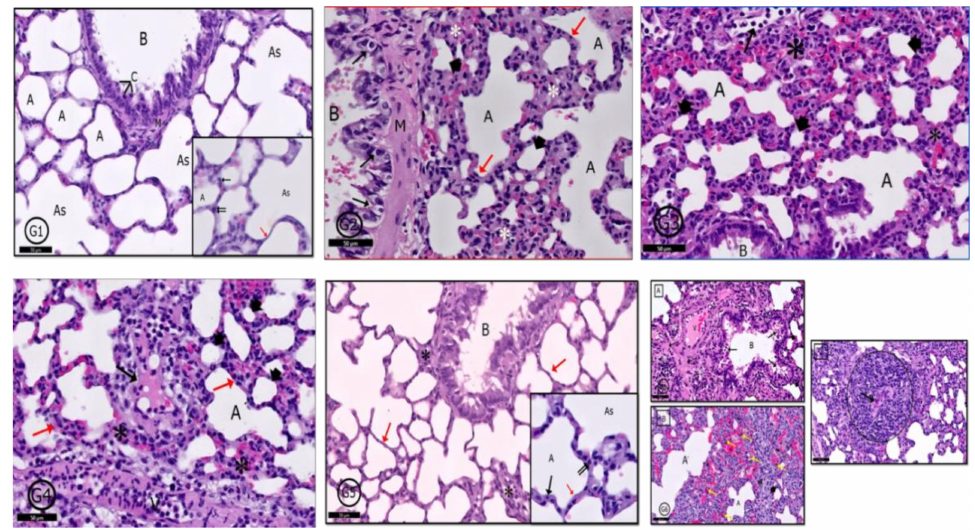
Figure 11. Photomicrographs of the rat lung of different groups: ( G1 ) (control rats) showed normal pulmonary profile as a bronchiole (B), alveolar sacs (As), alveoli (A) separated by interalveolar septa (red ↑ ) and arterioles (Ar). Clara cells (C), pneumocyte type I ( ↑ ) and pneumocytes type II ( ↑↑ ) are normal bronchial and alveolar cells (see inset also). In ( G2 ) (PILO rats), ( G3 ) (PILO+LPS rats) and ( G4 ) (PILO+LPS+VPA rats) a variety of degenerative and inflammatory cells were recorded; bronchiolar wall ( G2 -B) contains degenerated cells ( ↑ ). Mild thickening of alveolar walls in ( G2 ) transformed into marked thickening in ( G3 , G4 ) with inflammatory cells infiltration in the three groups (*—red ↑ in G2 , G4 ). Many alveoli showed emphysematous widening (A) and others showed narrowing of their lumens (head arrow). Some alveoli were occupied by inflammatory cells ( ↑ — G3 ) and there was inflammatory exudate in the thickened interalveolar septa ( ↑ — G4 ). ( G5 ) (PLC+LPS+Celecoxib rats) showed nearly normal pulmonary tissues however, localized inflammatory cells infiltration (*) around a bronchiole (B). The interalveolar septa appear thin in most areas (red ↑ ). Inset: Higher magnification of the pneumocytes shows pneumocyte type I ( ↑ ) and pneumocytes type II ( ↑↑ ). ( G6 ): (PILO+LPS+VPA+Celecoxib rats) showed A: inflammatory cells infiltration (*) surrounding the bronchiole (B), degenerated cells in bronchiolar lumen ( ↑ ), congested blood vessels (V) and acidophilic exudate in the interstitium (dot ↑ ). B: Narrow alveolar spaces (head arrow) and others dilated (A) with marked inflammatory cells infiltration and extravasated RBCs (*). The marked black dot appears in the interstitial tissue showing activated macrophages (yellow ↑ ). C: Granuloma with central caseating materials ( ↑ ). Stain: H&E. Bar 50 µ m. Inset ×